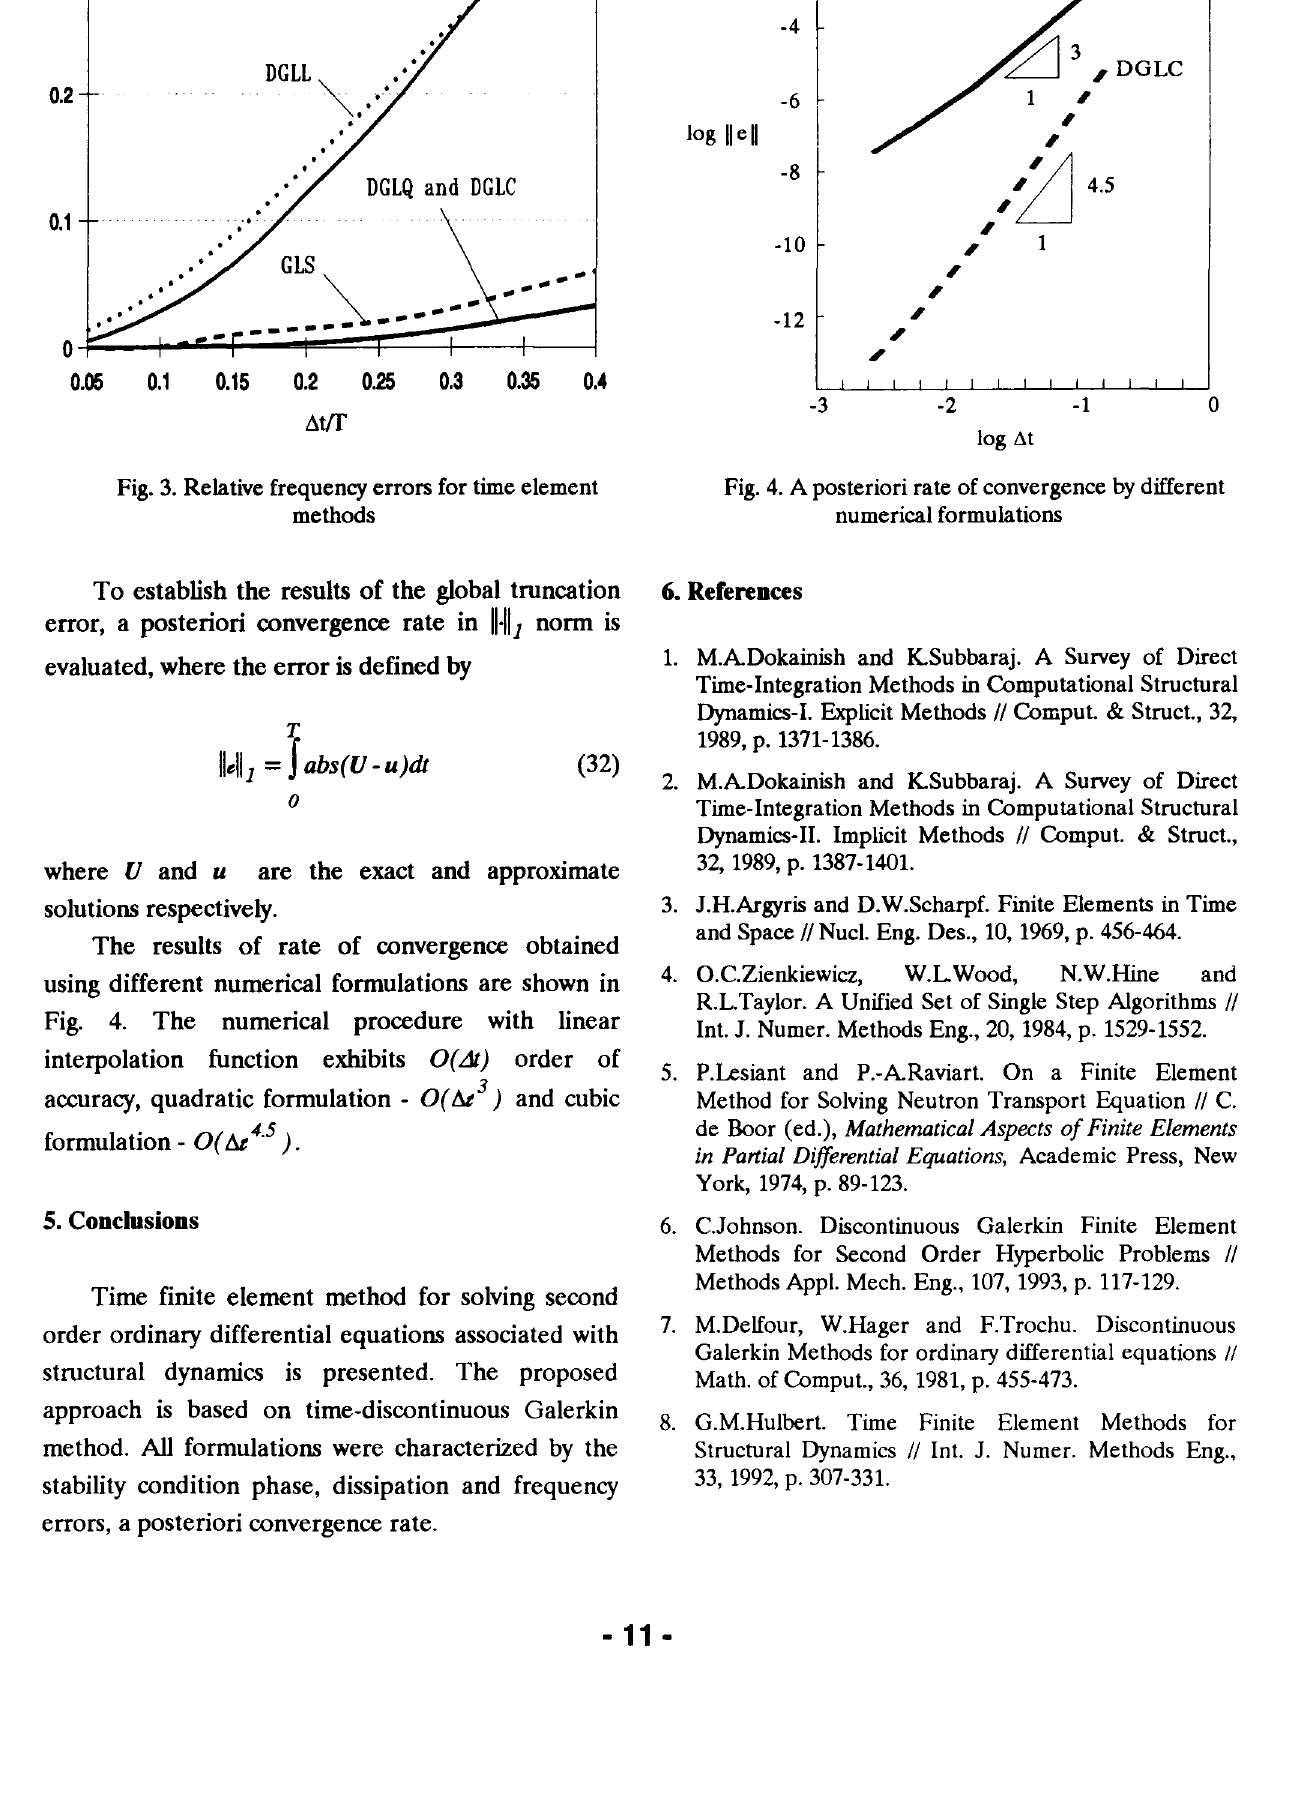
Fig. 3. Relative frequency errors for time element methods